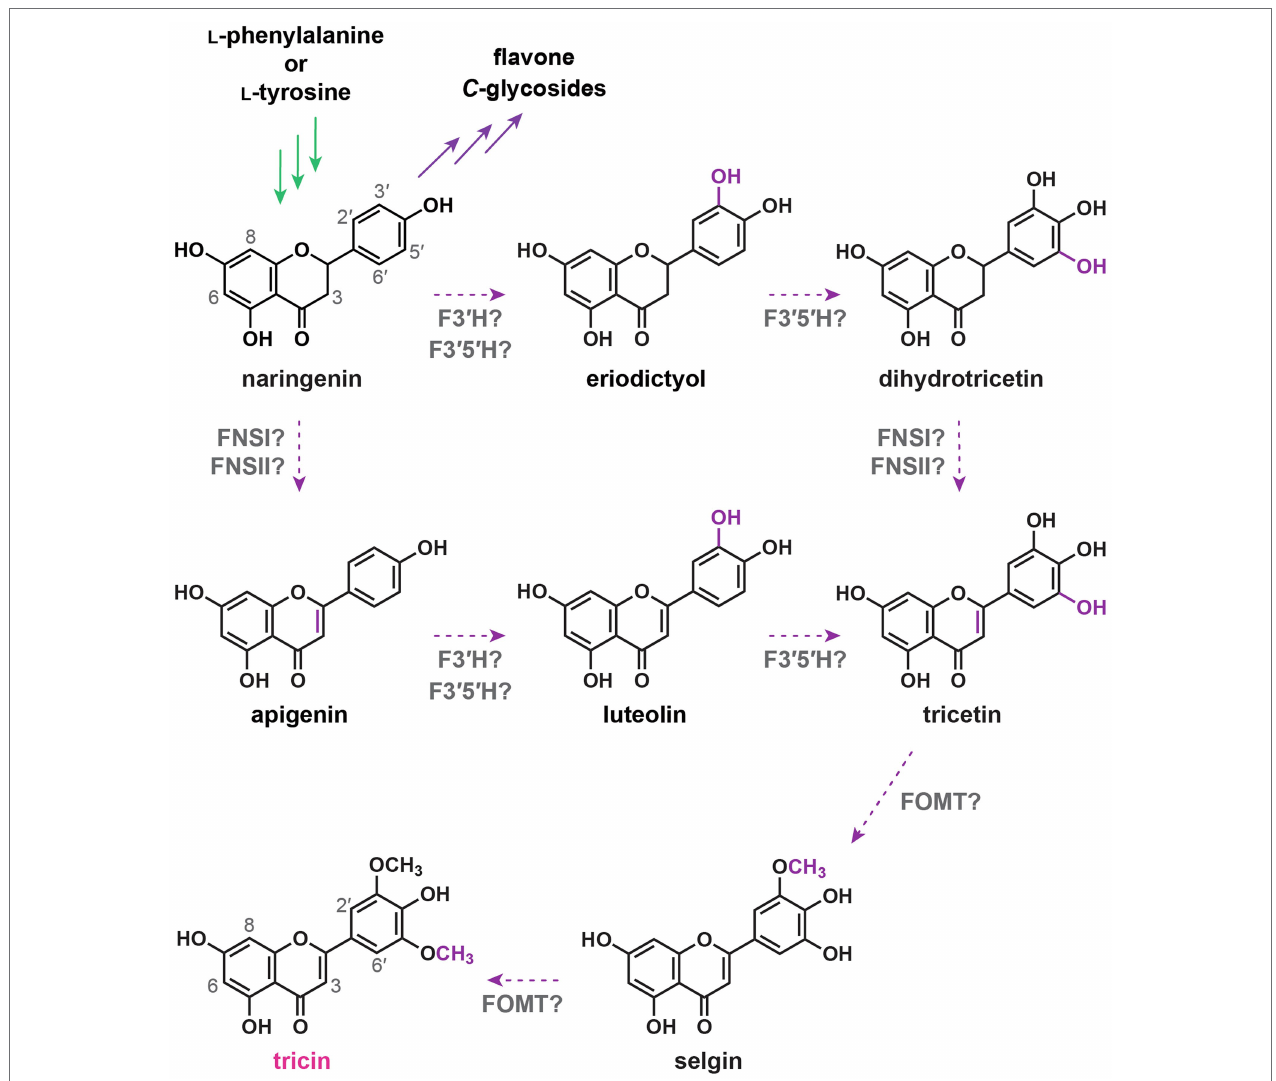
FIGURE 4 | Originally proposed tricin biosynthetic pathway. FNSI, flavone synthase I; FNSII, flavone synthase II; F3 ' H, flavonoid 3 ' -hydroxylase; F3 ' 5 ' H, flavonoid 3 ' ,5 ' -hydroxylase; and FOMT, flavonoid O -methyltransferase. In green: general phenylpropanoid pathway. In purple: flavonoid biosynthetic pathway. Dotted arrows: originally proposed tricin biosynthetic